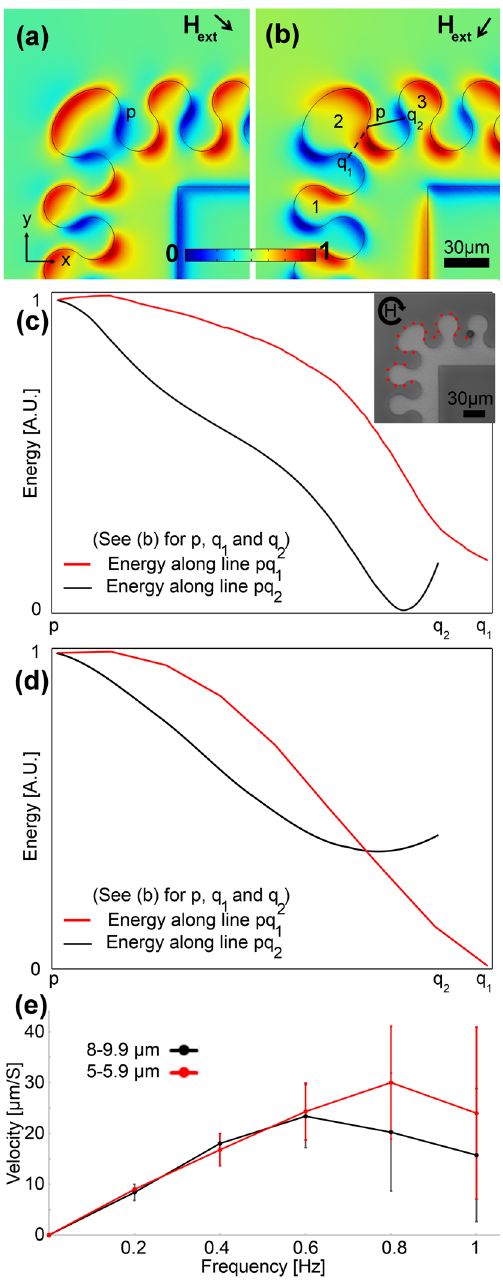
Figure 6. A sample appropriate magnetophoretic bend design. ( a , b ) The magnetic energy landscape simulation results above the substrate are illustrated. The blue and red regions stand for the regions with low and high magnetic energies, respectively. Here, we did a min–max normalization to scale the magnetic energy between 0 and 1 (see the legend). The black arrow depicts the in-plane magnetic field direction, in addition to which a vertical bias field is applied. The magnetic energies along the pq 1 and pq 2 lines in ( b ) (i.e., the dashed and solid lines) are plotted with the red and black curves for a particle with a diameter of ( c ) 5 µm and ( d ) 20 µm. The red dotted line in the inset in ( c ) illustrates a sample particle trajectory, where the circular arrow depicts the magnetic field rotation. The goal is to transport the particles from magnet 1 to magnet 3 via magnet 2. We used a linear scale for the magnetic energy plots and we did a min–max normalization, using the minimum and maximum of the magnetic energy along the pq 1 and pq 2 paths, to scale the energy between 0 and 1. ( e ) The particle velocity versus frequency of the externally applied magnetic field is plotted with the black and red curves for two particle sets with sizes in the ranges of 5–5.9 µm and 8–9.9 µm, respectively. The error bars show standard